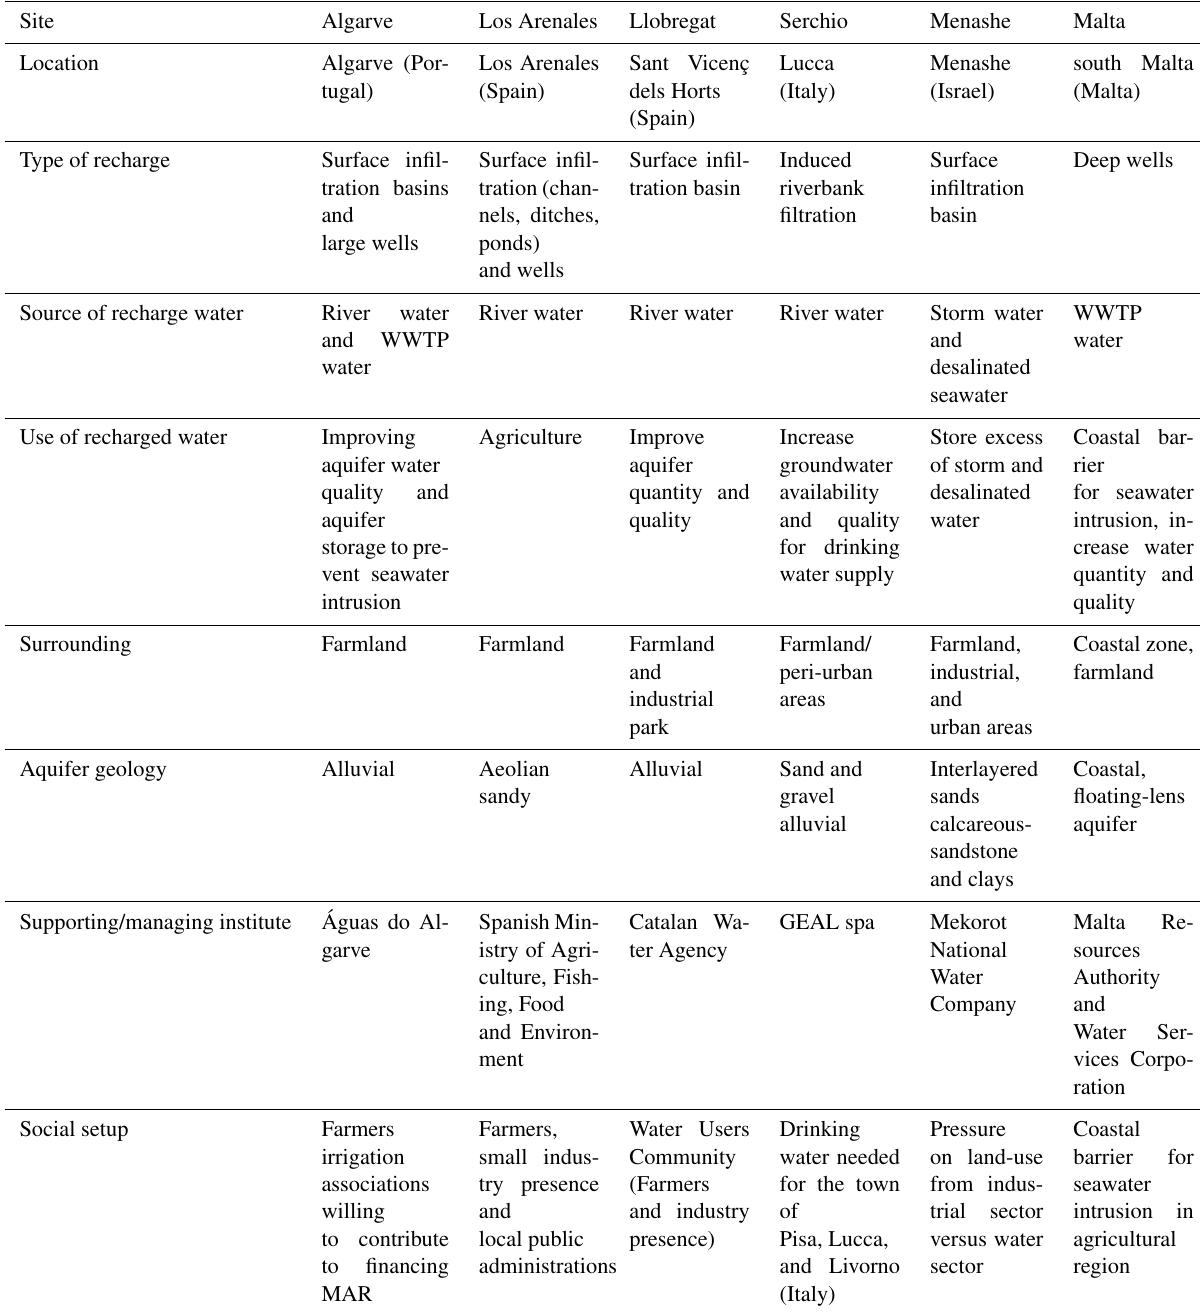
Table 2. Events of the fault tree divided by categories for non-technical and technical